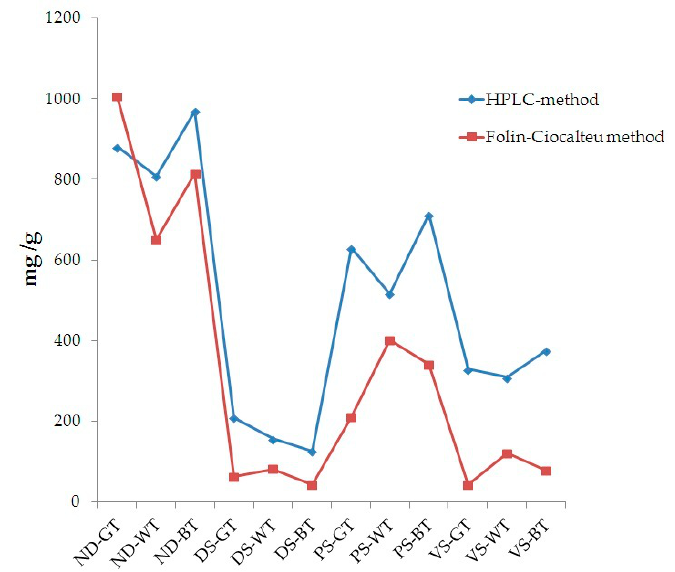
Figure 2. Comparison between the data obtained by the HPLC-DAD method and the spectrophotometric Folin-Ciocalteu method, expressed as mg/g total polyphenols and mg/g gallic acid, respectively.